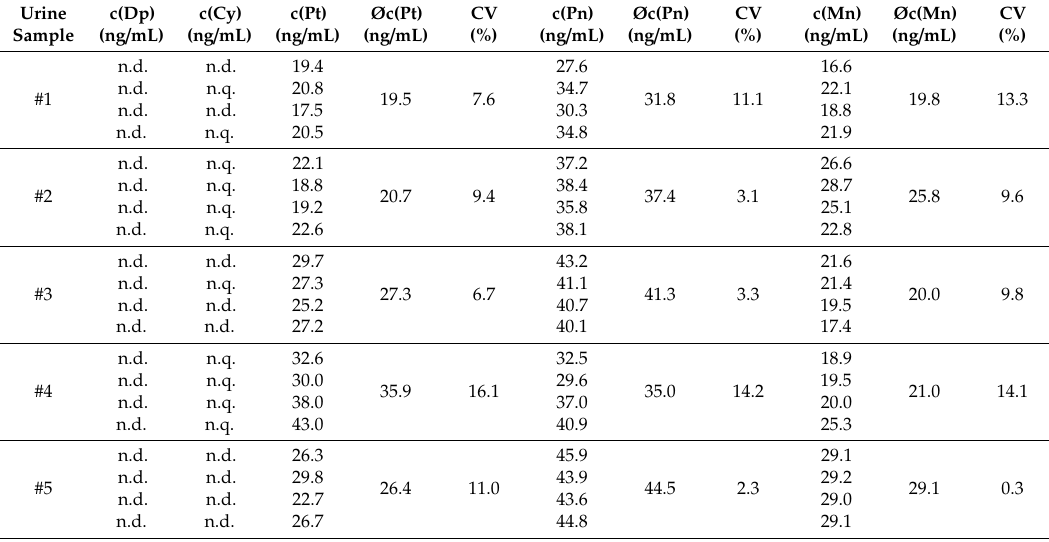
Table 3. Results of the analysis of real urine